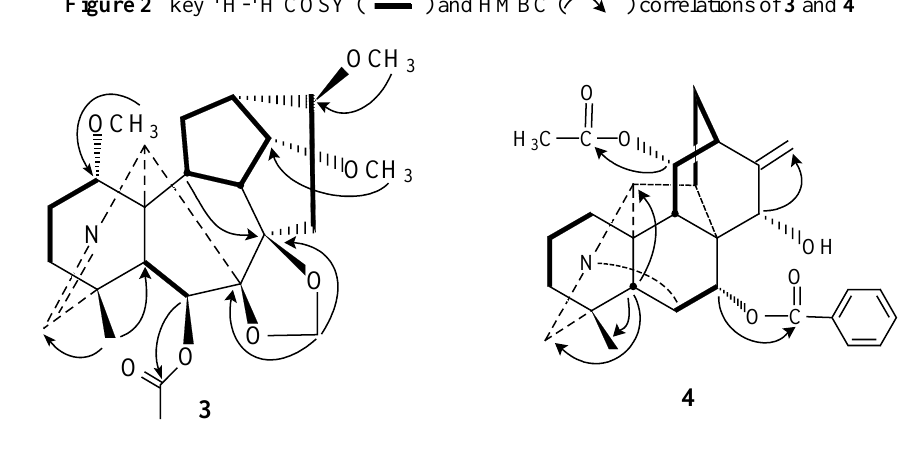
Figure 2 key 1 H-1 H COSY ( ) and HMBC